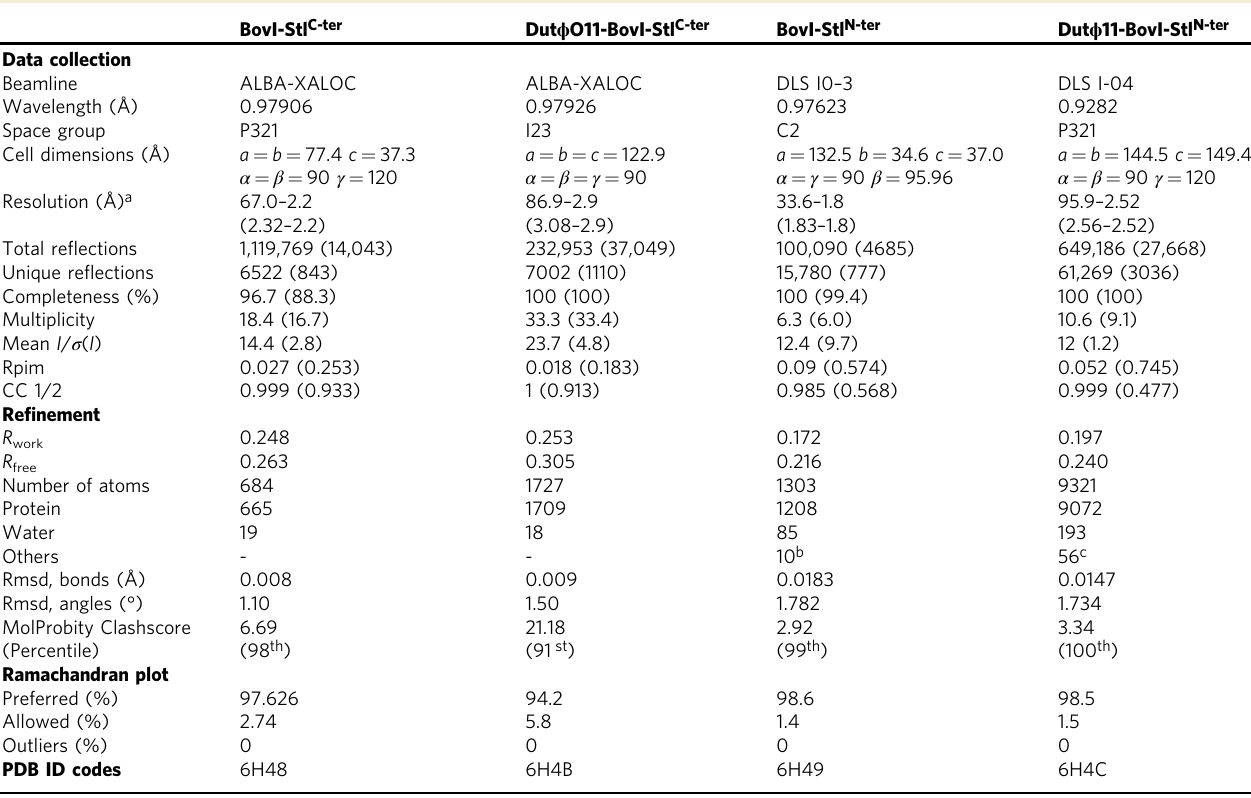
Table 1 Data collection and re fi nement